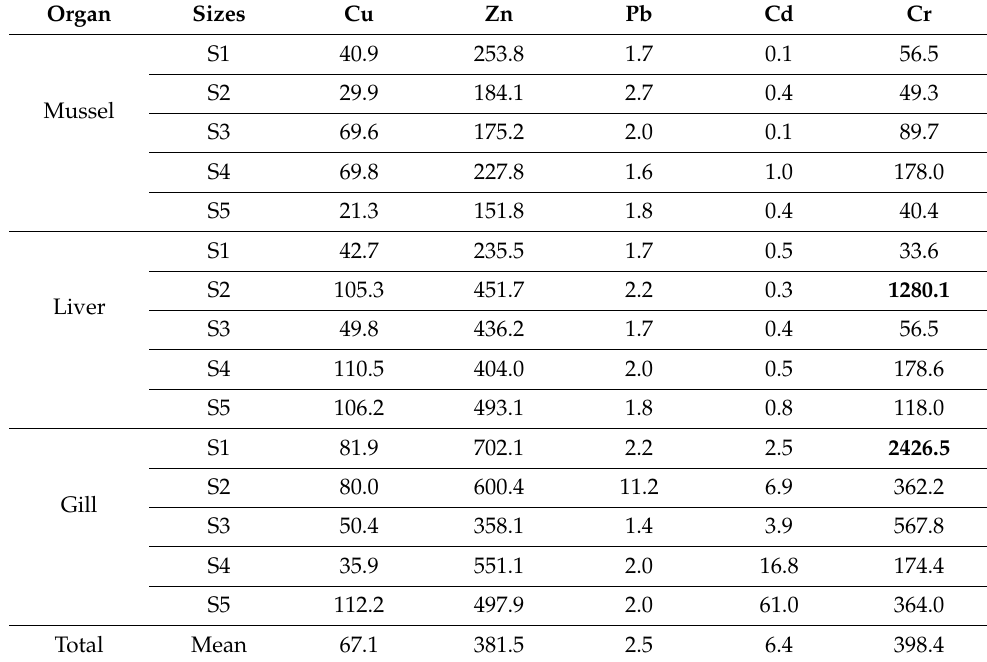
Table 5. Bioaccumulation factors of heavy metals in muscles, liver, and gills of the different size classes of T . ilisha . Bold is used to identify bio-accumulative